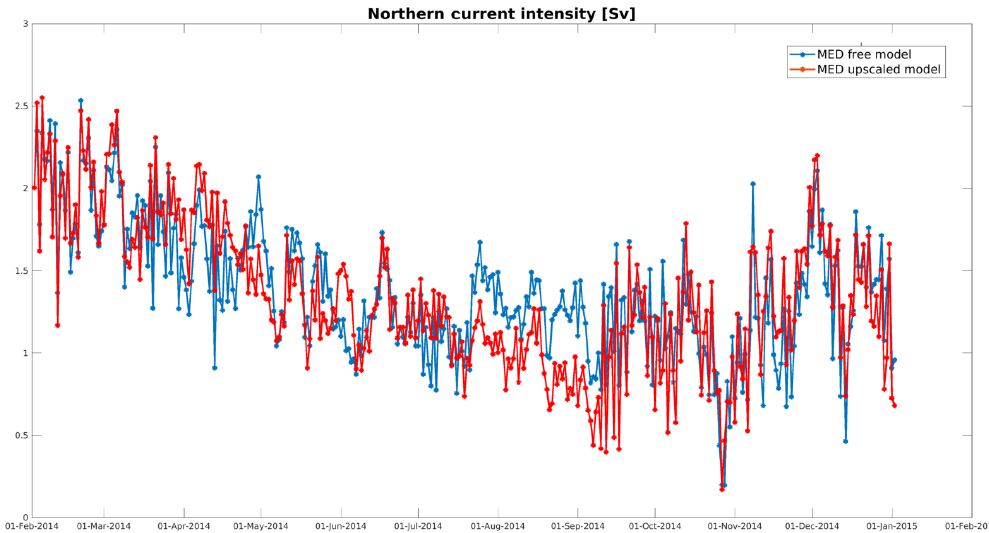
Figure 7. Water transport by the Northern Current off Nice (France) during 2014, as obtained by the free (blue curve) and upscaled (red curve) parent